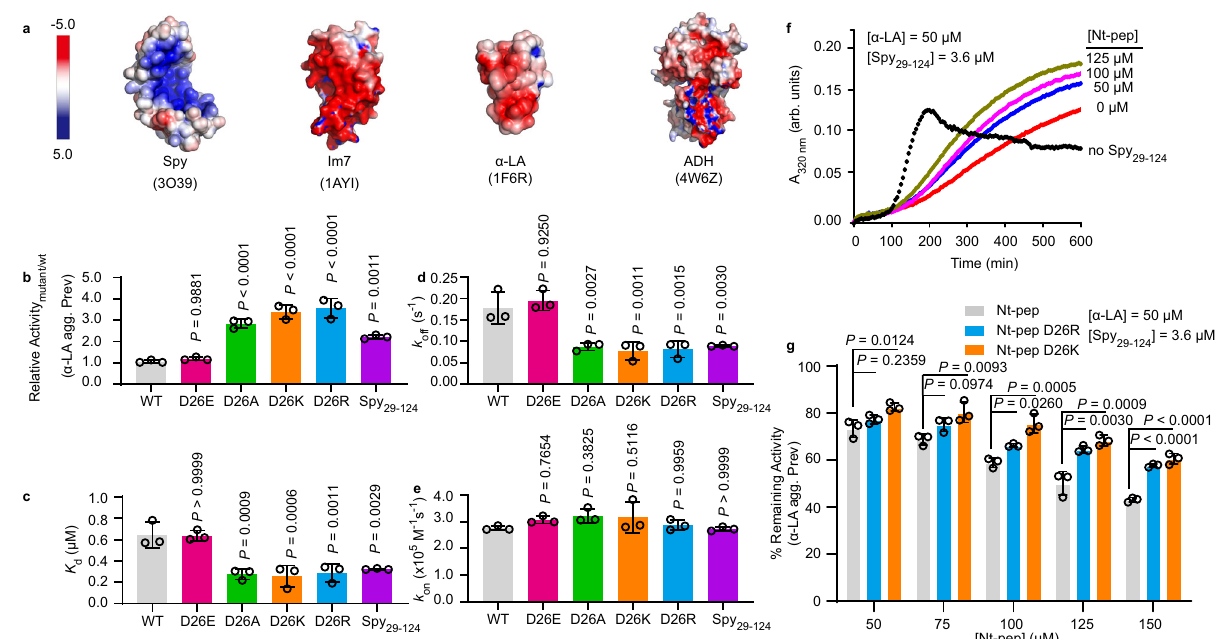
Fig. 2 The D26 residue located on Spy ’ s disordered N terminus facilitates client release. a Surface charge distribution of Spy and model client proteins. The concave, client-binding surface of Spy (PDB: 3O39) is predominantly positively charged (blue), while the surfaces of client proteins Im7 (1AYI), α -LA (1F6R), and ADH (4W6Z) are generally negatively charged (red). The electrostatic surface potential was calculated in PyMOL with the Adaptive Poisson- Boltzmann Solver tools 2.1 plugin. A color scale for the charge distribution ranging from – 5 to 5 was applied. b Chaperone activities of different Spy variants in preventing the aggregation of DTT-reduced α -LA relative to the activity of Spy wild type. Kinetic parameters characterizing the interactions between Spy variants and Im7 AAW , including the dissociation constants K d ( c ), dissociation rate constants k off ( d ), and association rate constants k on ( e ). f The anti- aggregation activity of Spy 29-124 in the presence and absence of various concentrations of Nt-pep. Representative curves from three independent measurements are shown. In the absence of Spy 29-124 , massive aggregation of α -LA resulted in the decline of the light scattering signal at 320 nm after 200 min (black curve). g Quanti fi cation for remaining anti-aggregation activities of Spy 29-124 in the presence of various concentrations of Nt-pep, Nt-pep D26K, and Nt-pep D26R. For b – e , g individual data points (circles) and mean ± SD ( n = 3 independent experiments) are shown. Statistical analysis was performed with Graphpad Prism 9.1.0 using one-way ANOVA with Tukey ’ s multiple comparisons test. α -LA agg. Prev means α -LA aggregation Prevention. Source data are provided as a Source Data fi